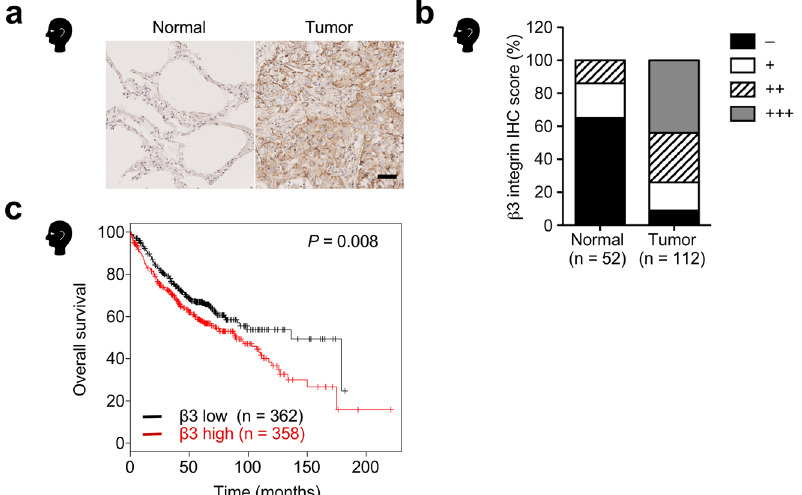
Fig. 1 Upregulation of β 3 integrin in lung adenocarcinoma is associated with poor survival. a Representative immunohistochemistry images of β 3 integrin expression in human normal lung and lung adenocarcinoma tumor tissues. Scale bar, 50 µ m. b β 3 integrin expression in human normal lung tissues ( n = 52) versus lung adenocarcinoma tumor tissues ( n = 112). The staining intensity was graded as follows: − (negative), + (weak), ++ (moderate), and +++ (strong). The source data are provided in Supplementary Data 1. c Kaplan-Meier analysis of the correlation between β 3 integrin expression and overall survival for lung adenocarcinoma patients ( n = 720) using the database Kaplan-Meier Plotter. P values were calculated using a log-rank